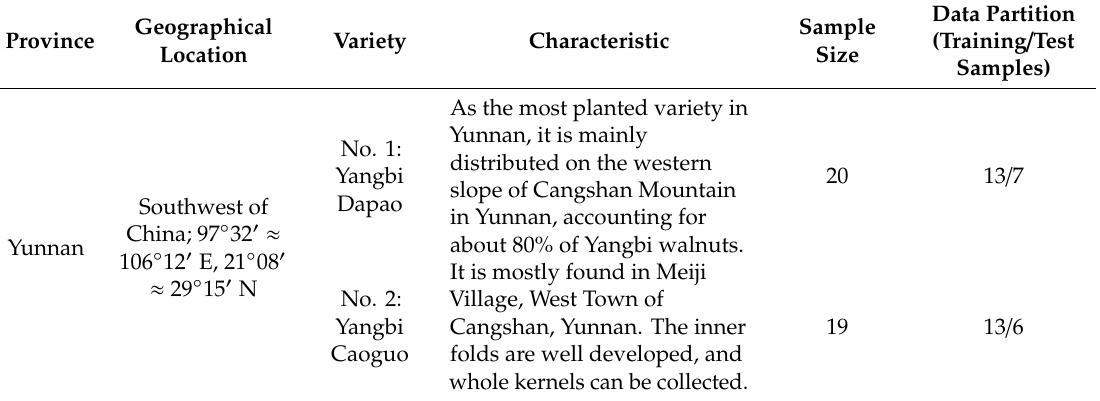
Table 4. Details of the collected walnut samples and the characterization of each